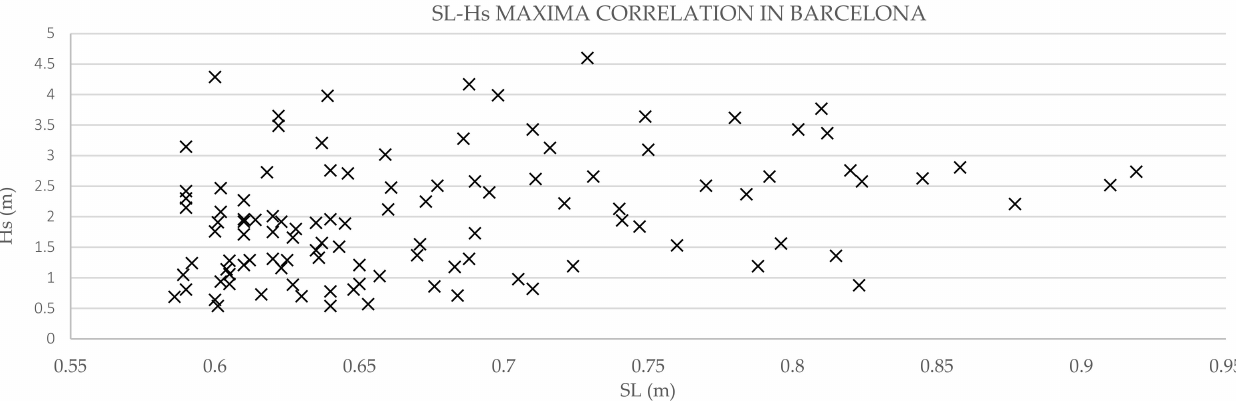
Figure 46. Correlation of extremes in